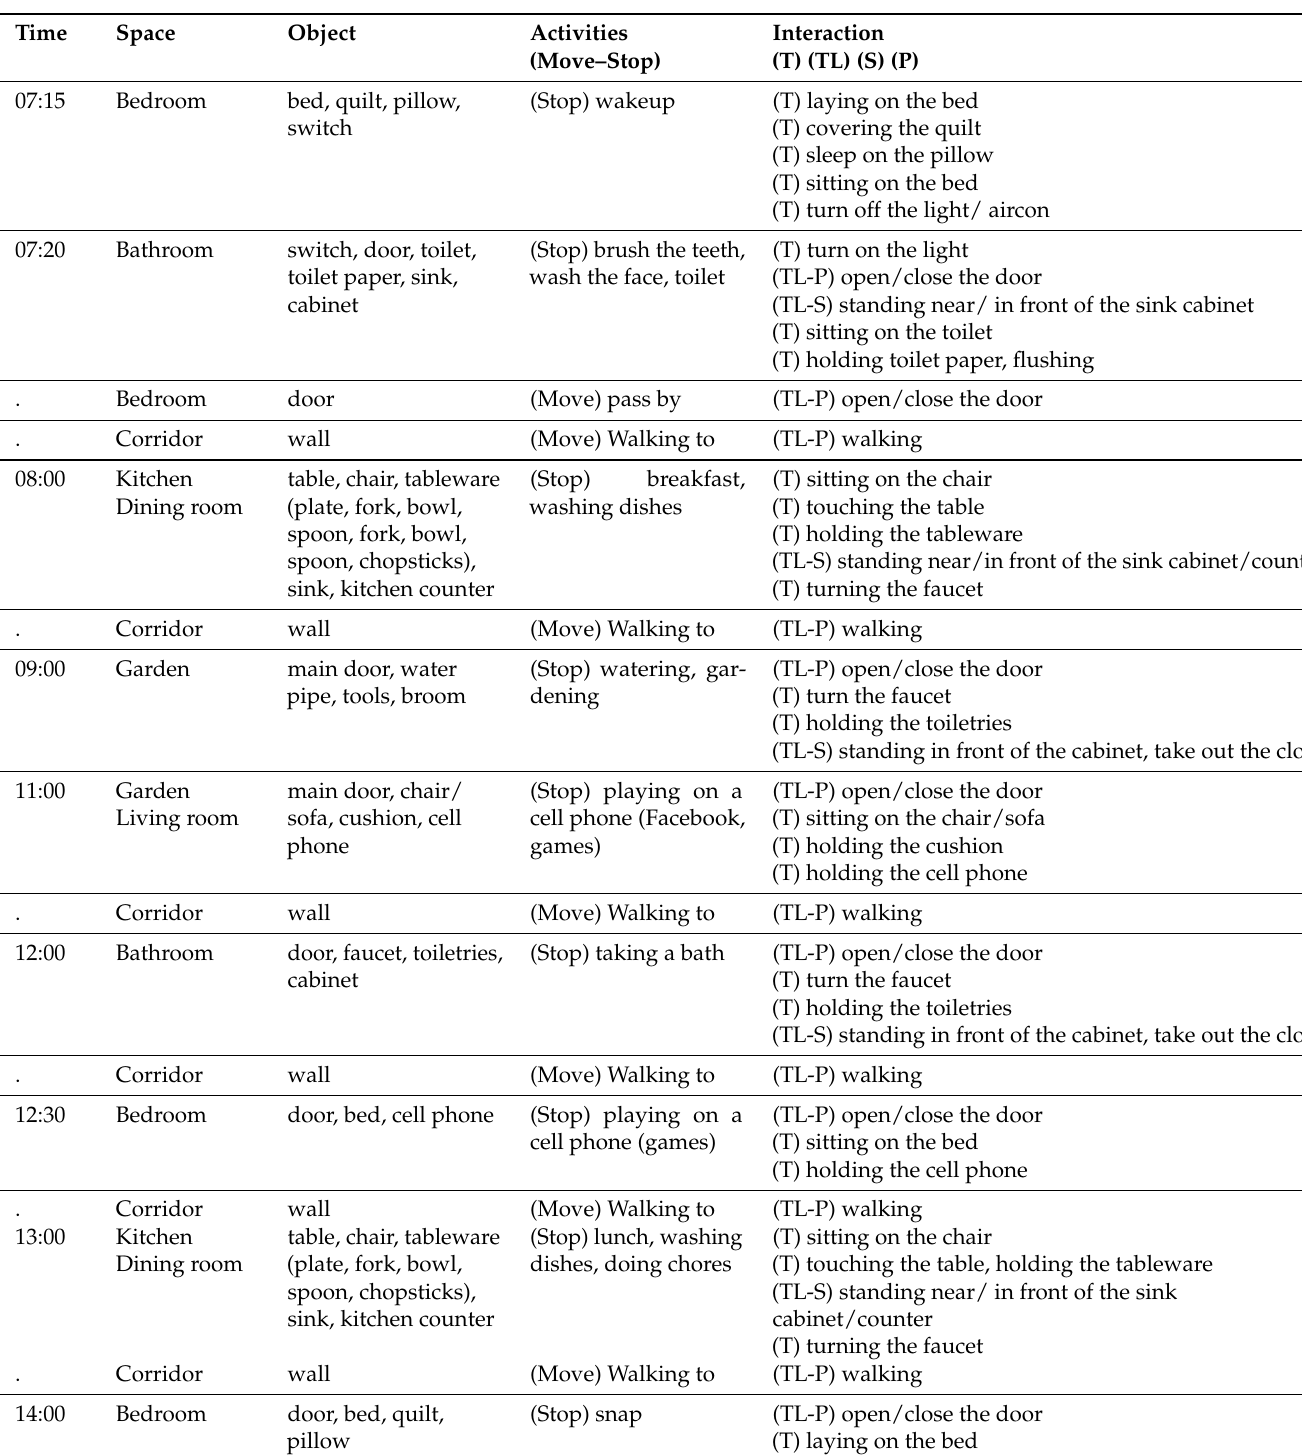
Table 1. Twenty-four hours of daily life behaviors and activities of the elderly